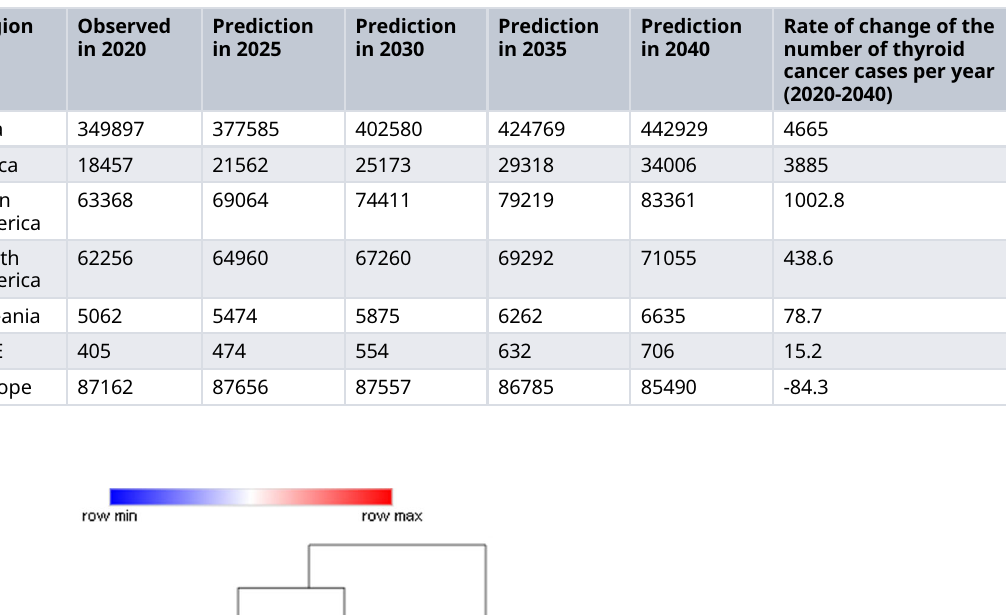
Table 1. The rate of change of thyroid cancer incidence from 2020 to 2040 using predictive model data.